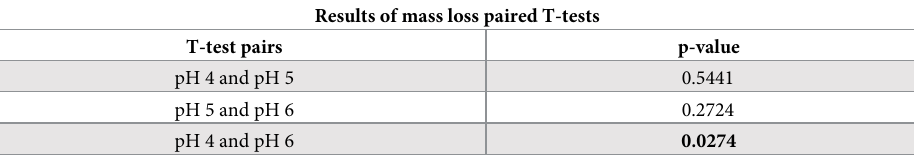
Table 2. Paired T-test results of mass loss.